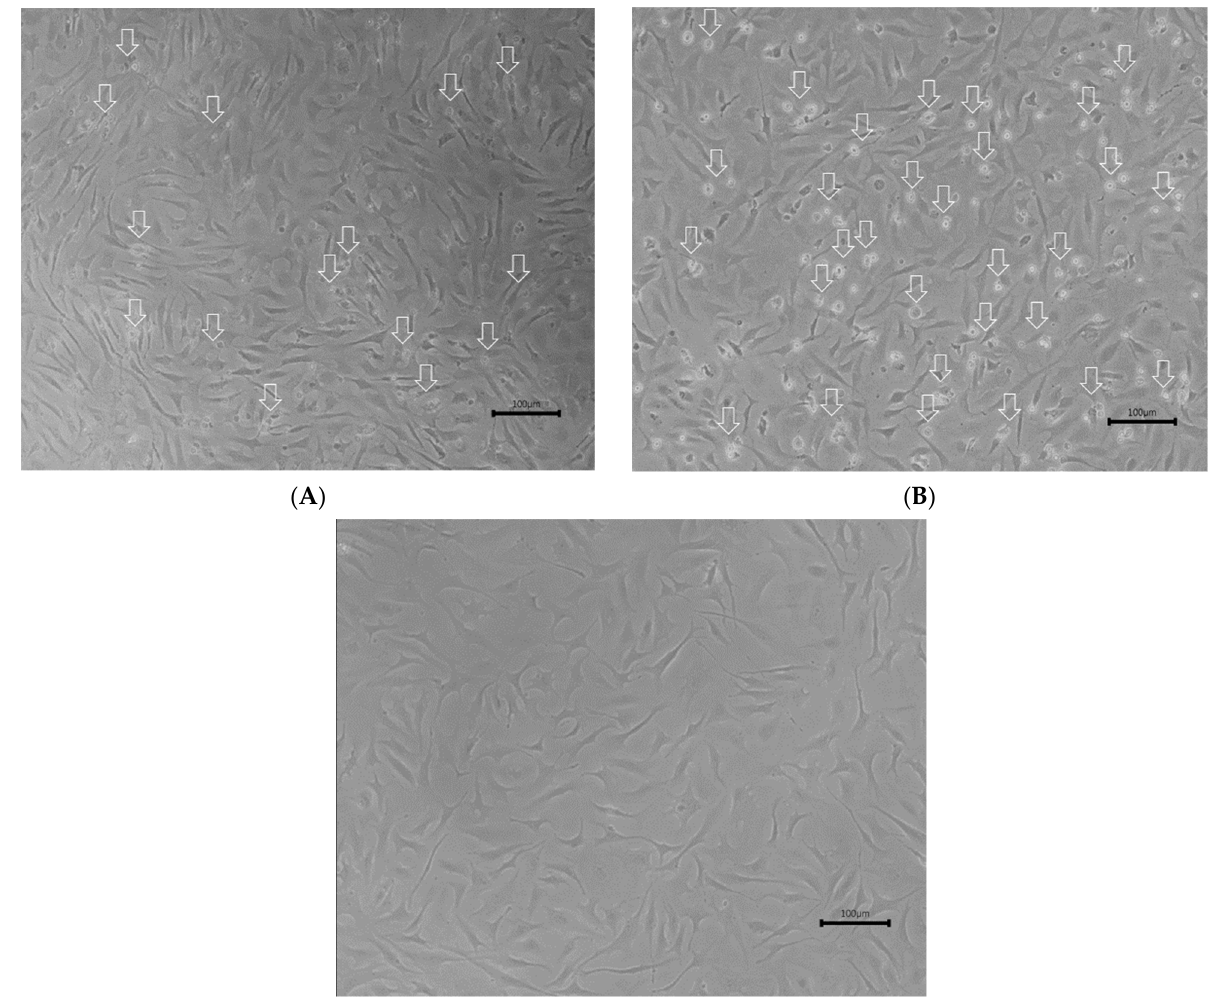
Figure A1. Cytopathic effects (CPEs) in rock bream fin cells under the influence of a tissue homogenate from ( A ) an RSIV (17SbTy)-infected Japanese seabass and ( B ) an RSIV (17RbGs)-infected rock bream. CPE of the rounding cells (arrows) in rock bream fin cells ( A ) after 3 days of inoculation with 17SbTy, and ( B ) 9 days of inoculation with 17RbGs, and ( C ) negative control (mock cells at passage 15). Scale bar = 100 μ m.